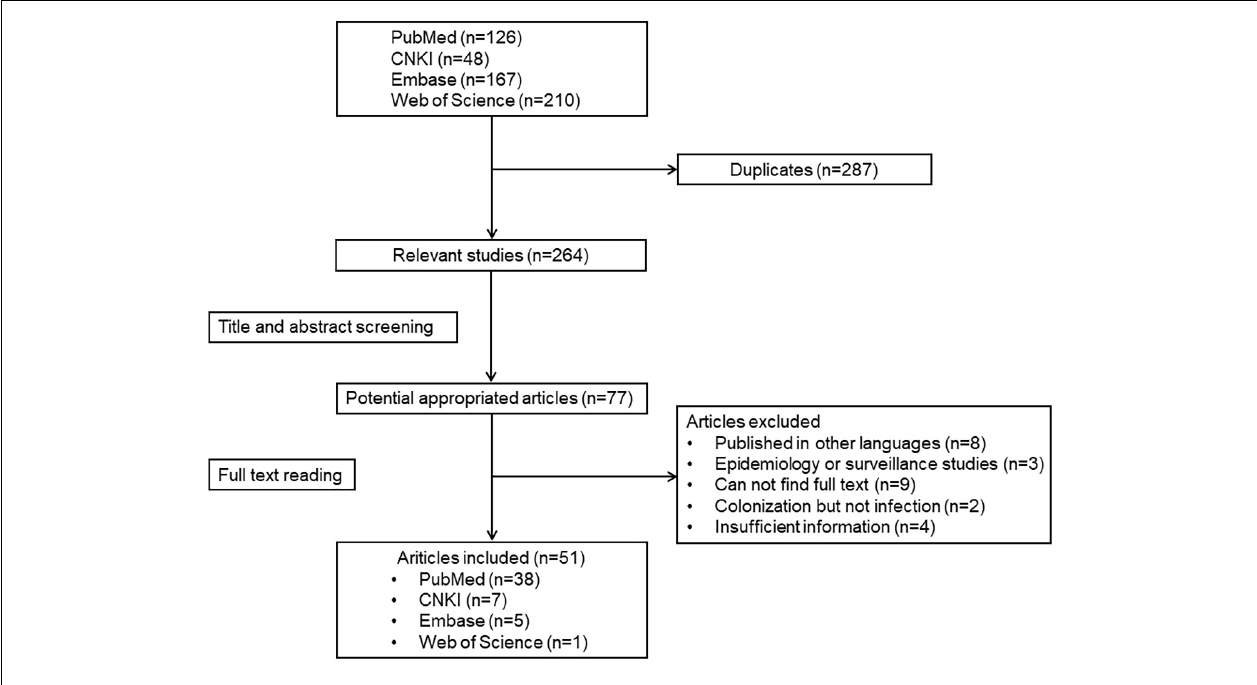
FIGURE 1 | Results of systemic literature